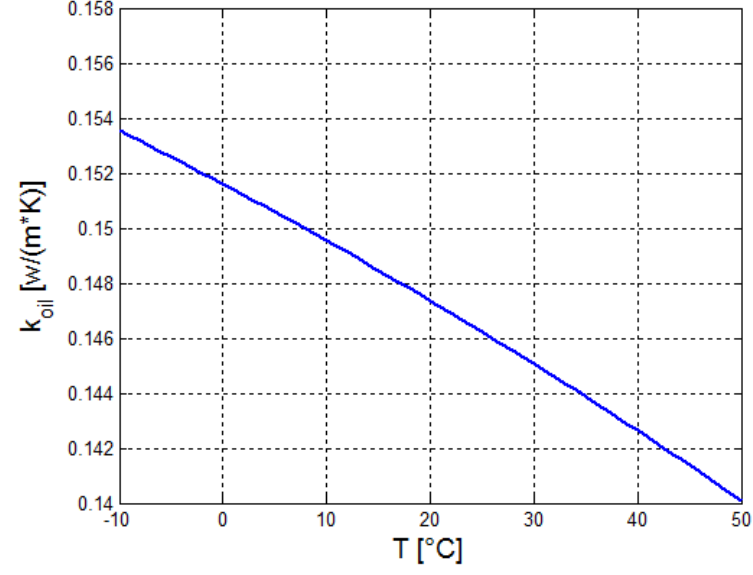
Figure 7. The thermal conductivity of liquid crude oil.